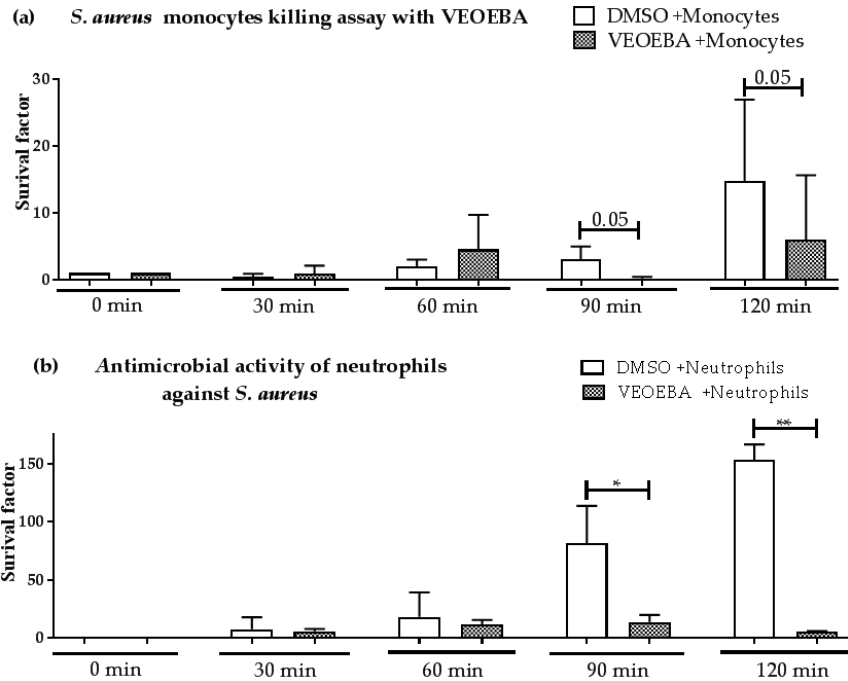
Figure 3. VEOEBA enhances the antimicrobial effect of monocytes ( a ) and neutrophils ( b ) against S. aureus . Depicted are bacterial survival factors at defined time points compared to t = 0 from a minimum of n = 3 independent experiments. * p < 0.05 one-tailed, paired Student’s t -test.